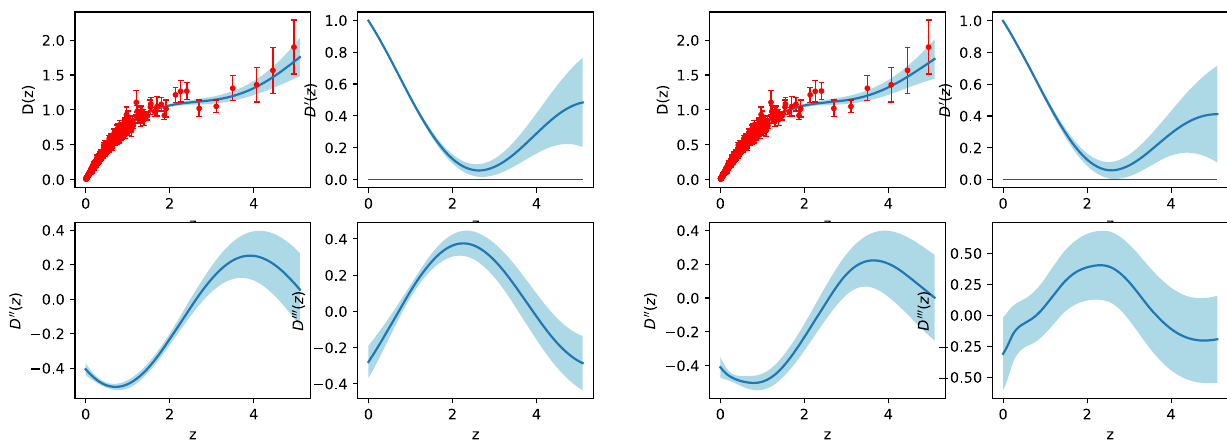
Fig. 4 Left panel: The reconstruction of D ( z ) and its derivatives as a function of redshift using Gaussian kernel by considering SNIa and QSOs. Right panel: The same plot using Matern ( ν = 7 / 2) kernel and the same data set Table 1 Cosmokinetic Data set Kernel parameters at present time for different data sets and kernels